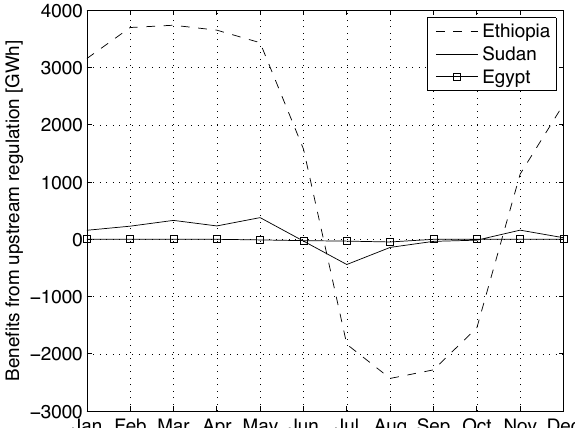
Fig. 11. Temporal repartition of benefits (hydropower) from upstream regulation.